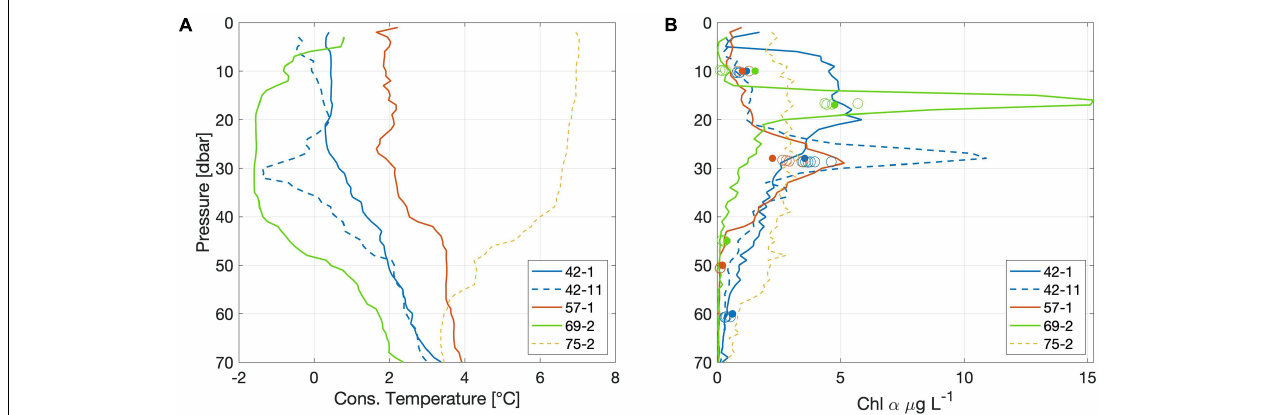
FIGURE 7 | Profiles of (A) conservative temperature ( ◦ C), and (B) chlorophyll a ( µ g L − 1 ) from CTD-stations close to the AUV-dive location. Chlorophyll a concentration observed with the CTD sensor during the down- (continuous and dashed lines) and upcasts (empty circles, showing values associated with bottle data from selected depths), as well as concentrations measured from water samples (filled circles). Legends indicate station numbers and are shown in the map in Figure 1